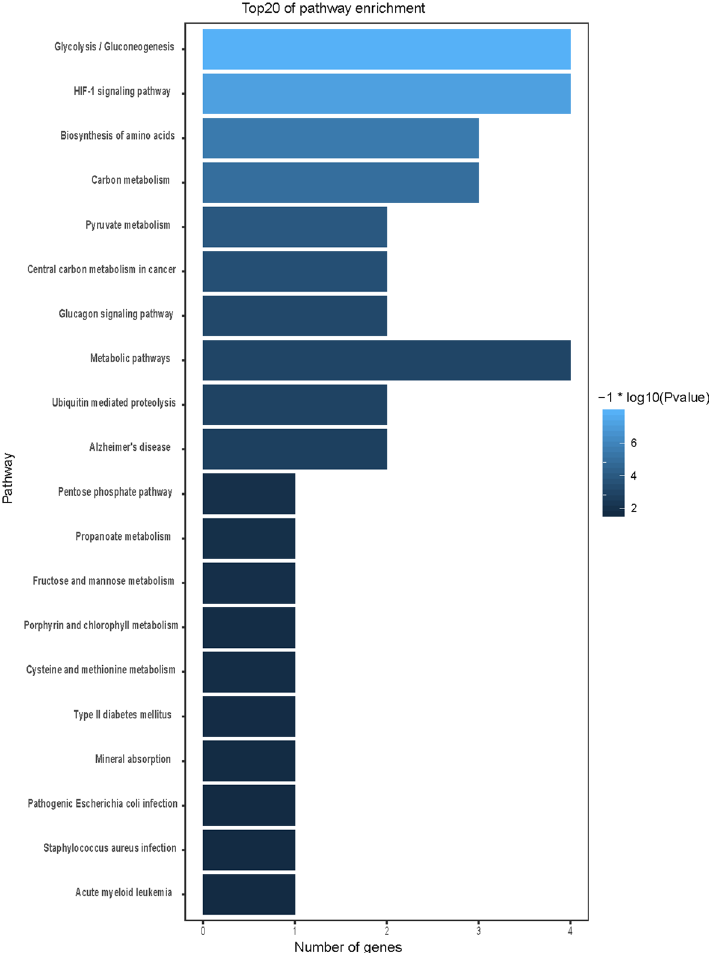
Figure 9. Calculated results of KEGG functional enrichment. Glycolysis/gluconeogenesis (KEGG: 00010) and HIF-1 signalling pathway (KEGG: 04,066) were the main KEGG pathways